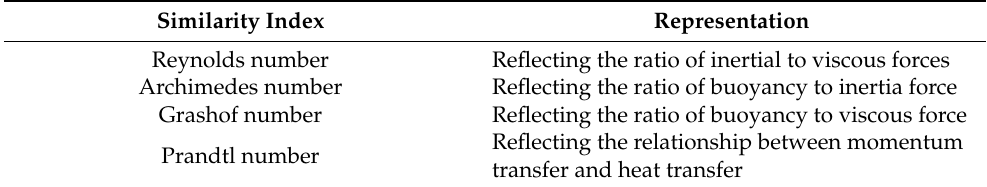
Table 2. Similarity index for fluid mechanics and heat transfer. Similarity Index Representation Reynolds number Reflecting the ratio of inertial to viscous forces Archimedes number Reflecting the ratio of buoyancy to inertia force Grashof number Reflecting the ratio of buoyancy to viscous force Reflecting the relationship between momentum Prandtl number transfer and heat transfer